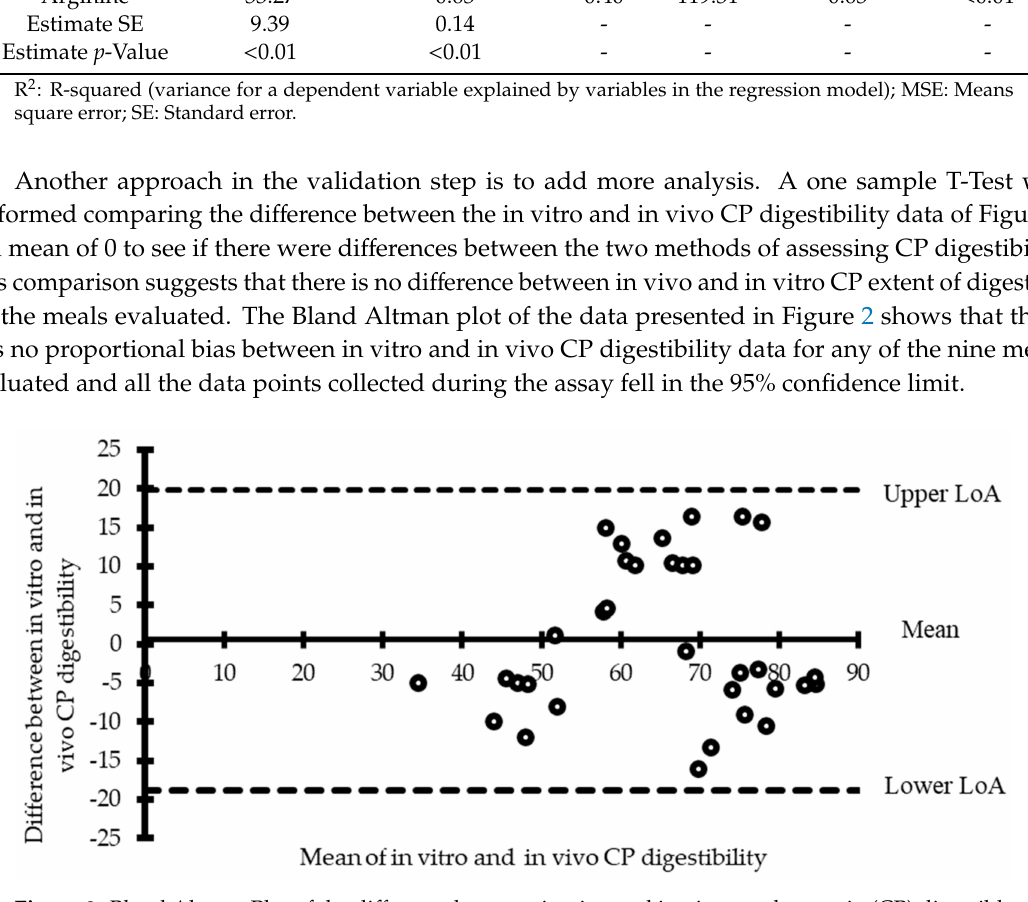
Figure 2. Bland Altman Plot of the di ff erence between in vivo and in vitro crude protein (CP) digestible of nine high protein feed ingredients [93]; LoA: limits of